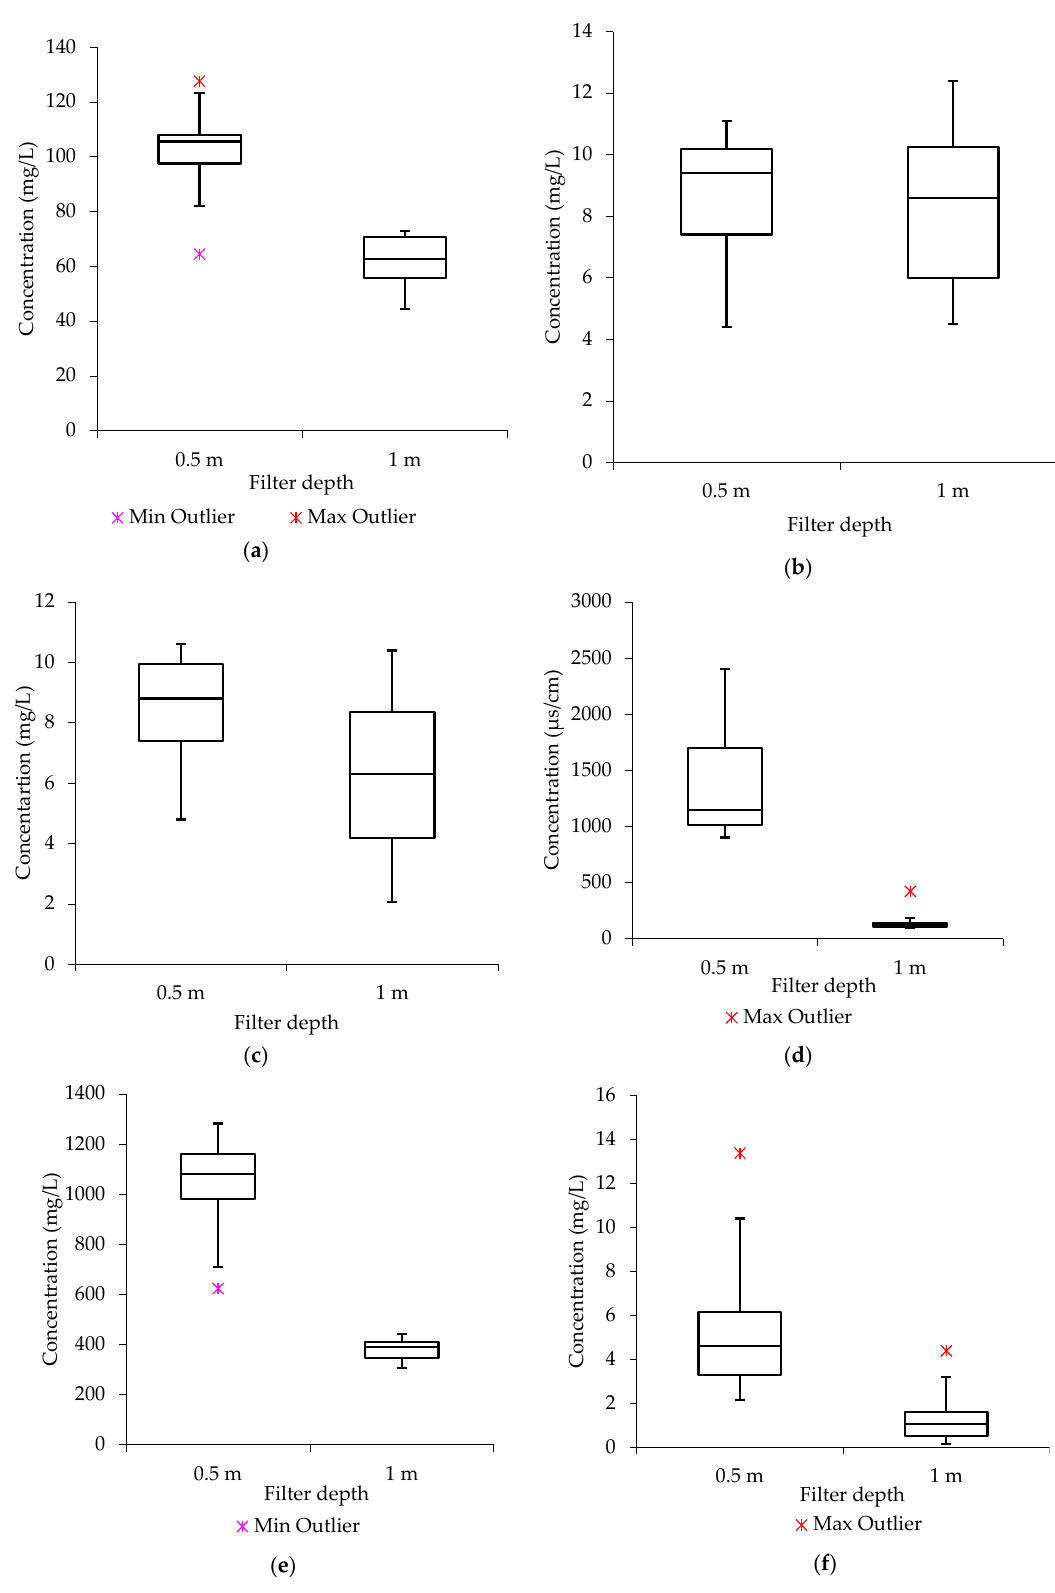
Figure 2. Data distribution after treatment (V f : 0.0035 L/s; pH: 6.4–12.5; T: 22.6–24.4 °C; n = 8) ( a ) sodium (Na + ) ( b ) calcium (Ca 2+ ) ( c ) magnesium (Mg 2+ ) ( d ) electrical conductivity (EC) ( e ) total dissolved solids (TDS) ( f ) potassium (K + ).